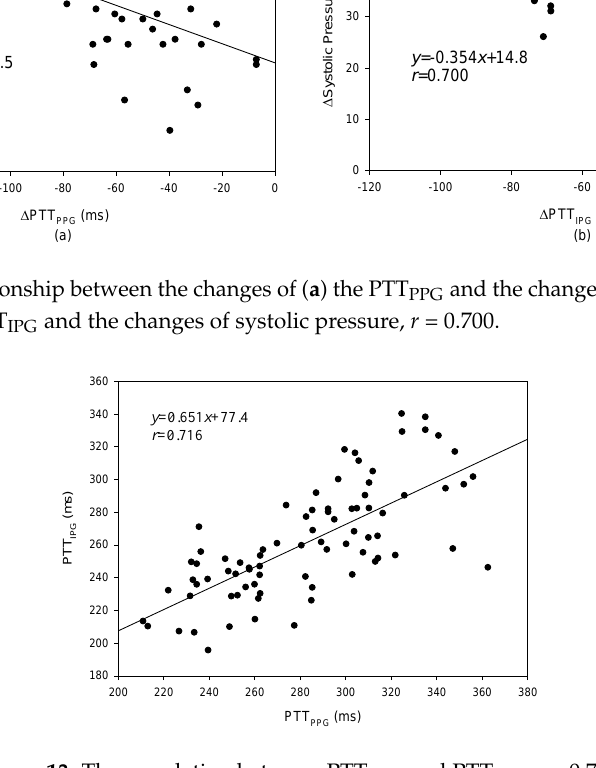
Figure 13. The correlation between PTT PPG and PTT IPG , r = 0.716.